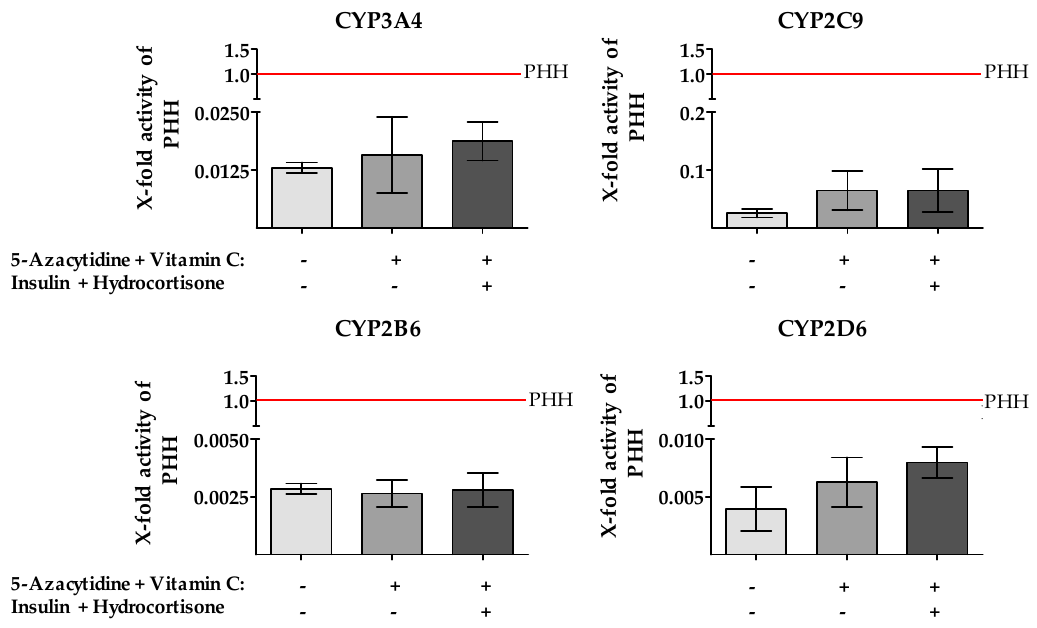
Figure 6. Activities of Cytochrome P450 (CYP) enzymes involved in drug metabolism are slightly increased after treatment with 5-Azacytidine (5-AZA) and Vitamin C. Supernatants were collected after incubation with specific substrates as indicated in materials and methods (4.4.6). Unstimulated HepG2 cells (grey bars) as well as HepG2 cells after 48 h stimulation with 10 µ M 5-AZA plus 0.5 mM Vitamin C with (dark bars) / without (black bars) insulin and hydrocortisone were used. For control, freshly isolated primary human hepatocytes (PHH) from three donors were used, shown as red line. Bars represent mean ± SEM of three independent experiments; supernatants of at least three wells were pooled.